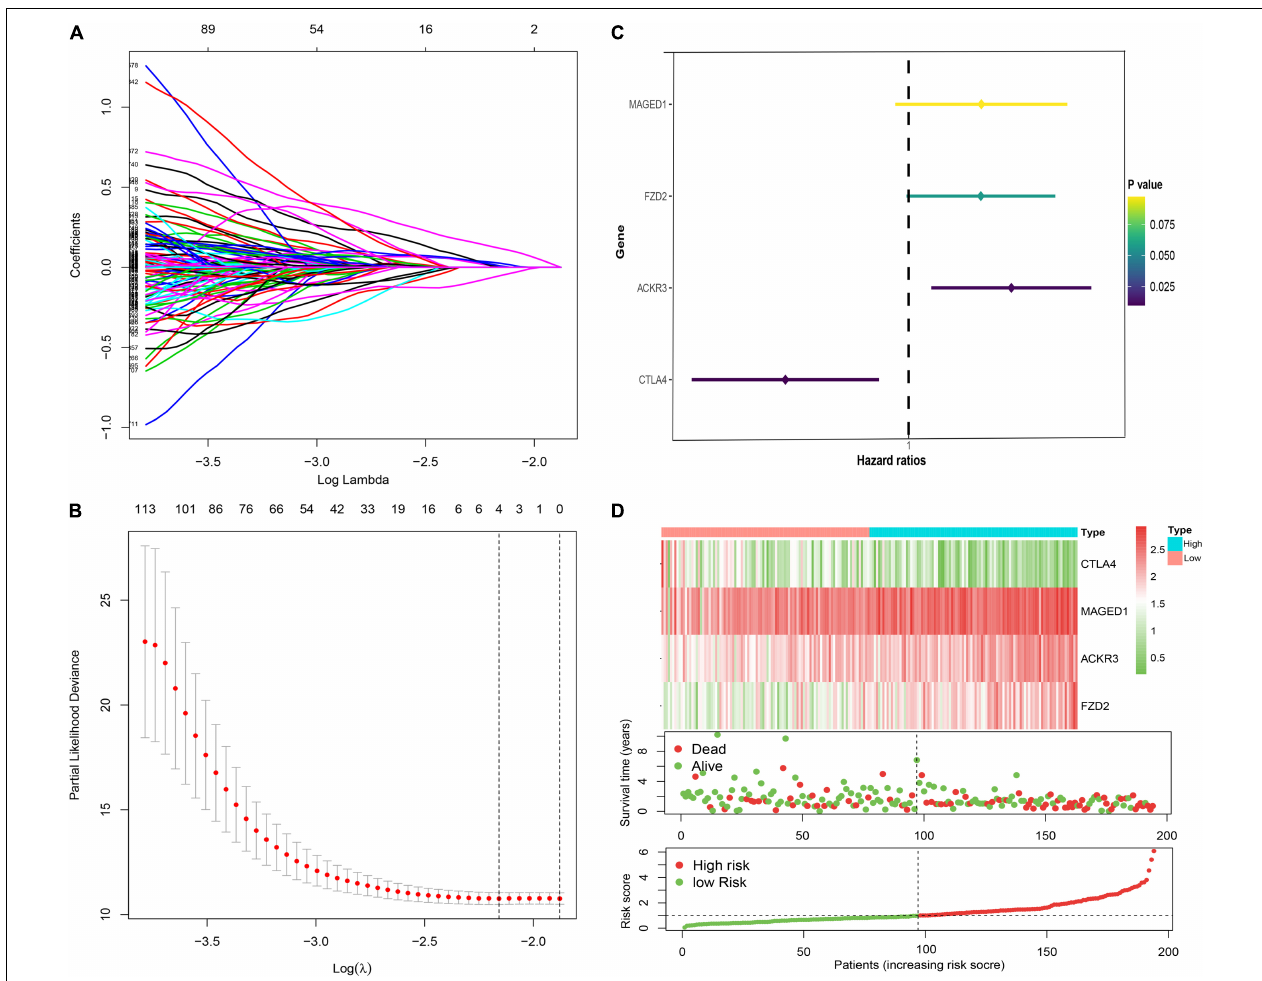
FIGURE 2 | Construction of the immune risk signature model. Lasso regression analysis (A,B) and multivariate stepwise Cox regression analysis (C) for identification of the immune risk signature; expression heat map (upper), survival status (middle), and risk score (bottom) of the signature consisting of four immune-related genes were depicted (D)